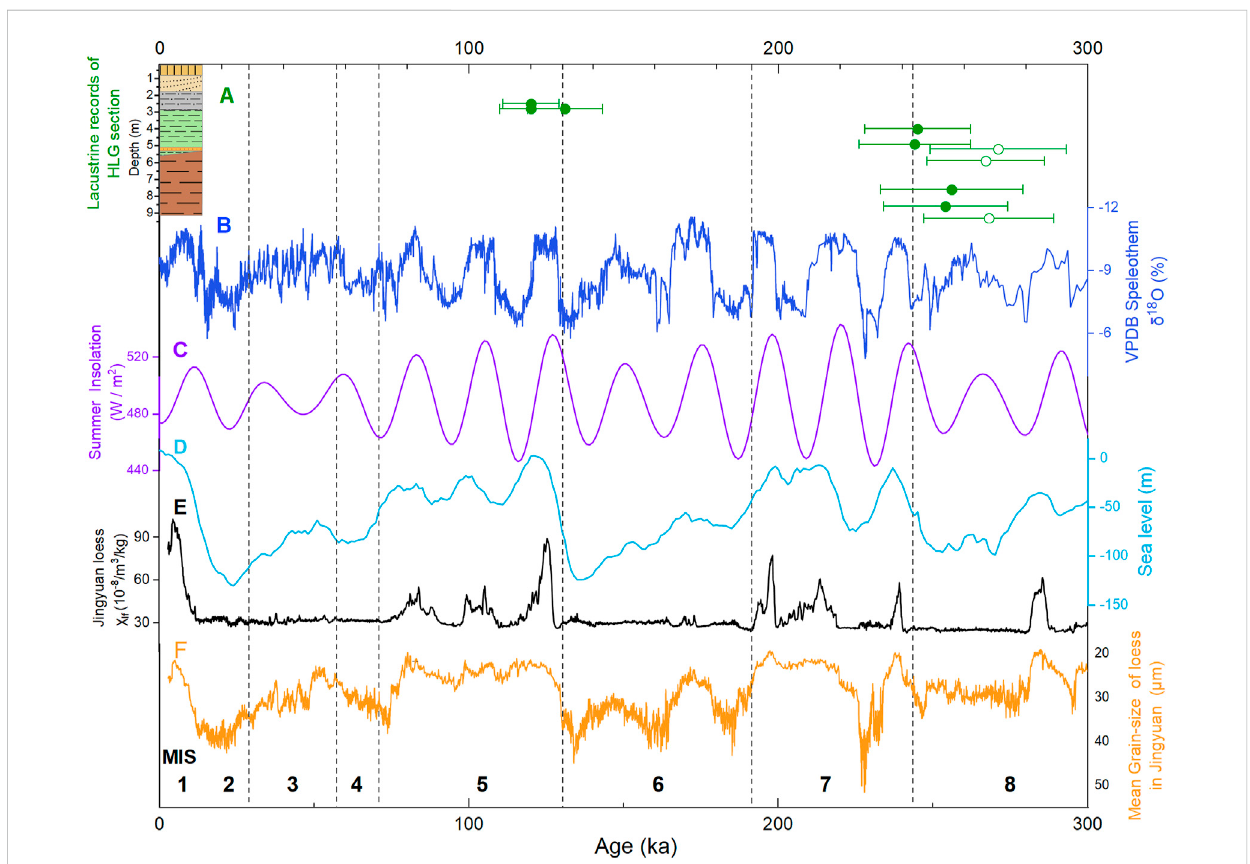
FIGURE 7 Comparison of (A) formation time of HTPL with (B – F) regional and global climatic records. Legends of A are the same as those in Figure 4, and ages marked with green circles are not used. (B) δ 18O records of cave stalagmites in regions controlled by ASM (Cheng et al., 2016). (C) Summer